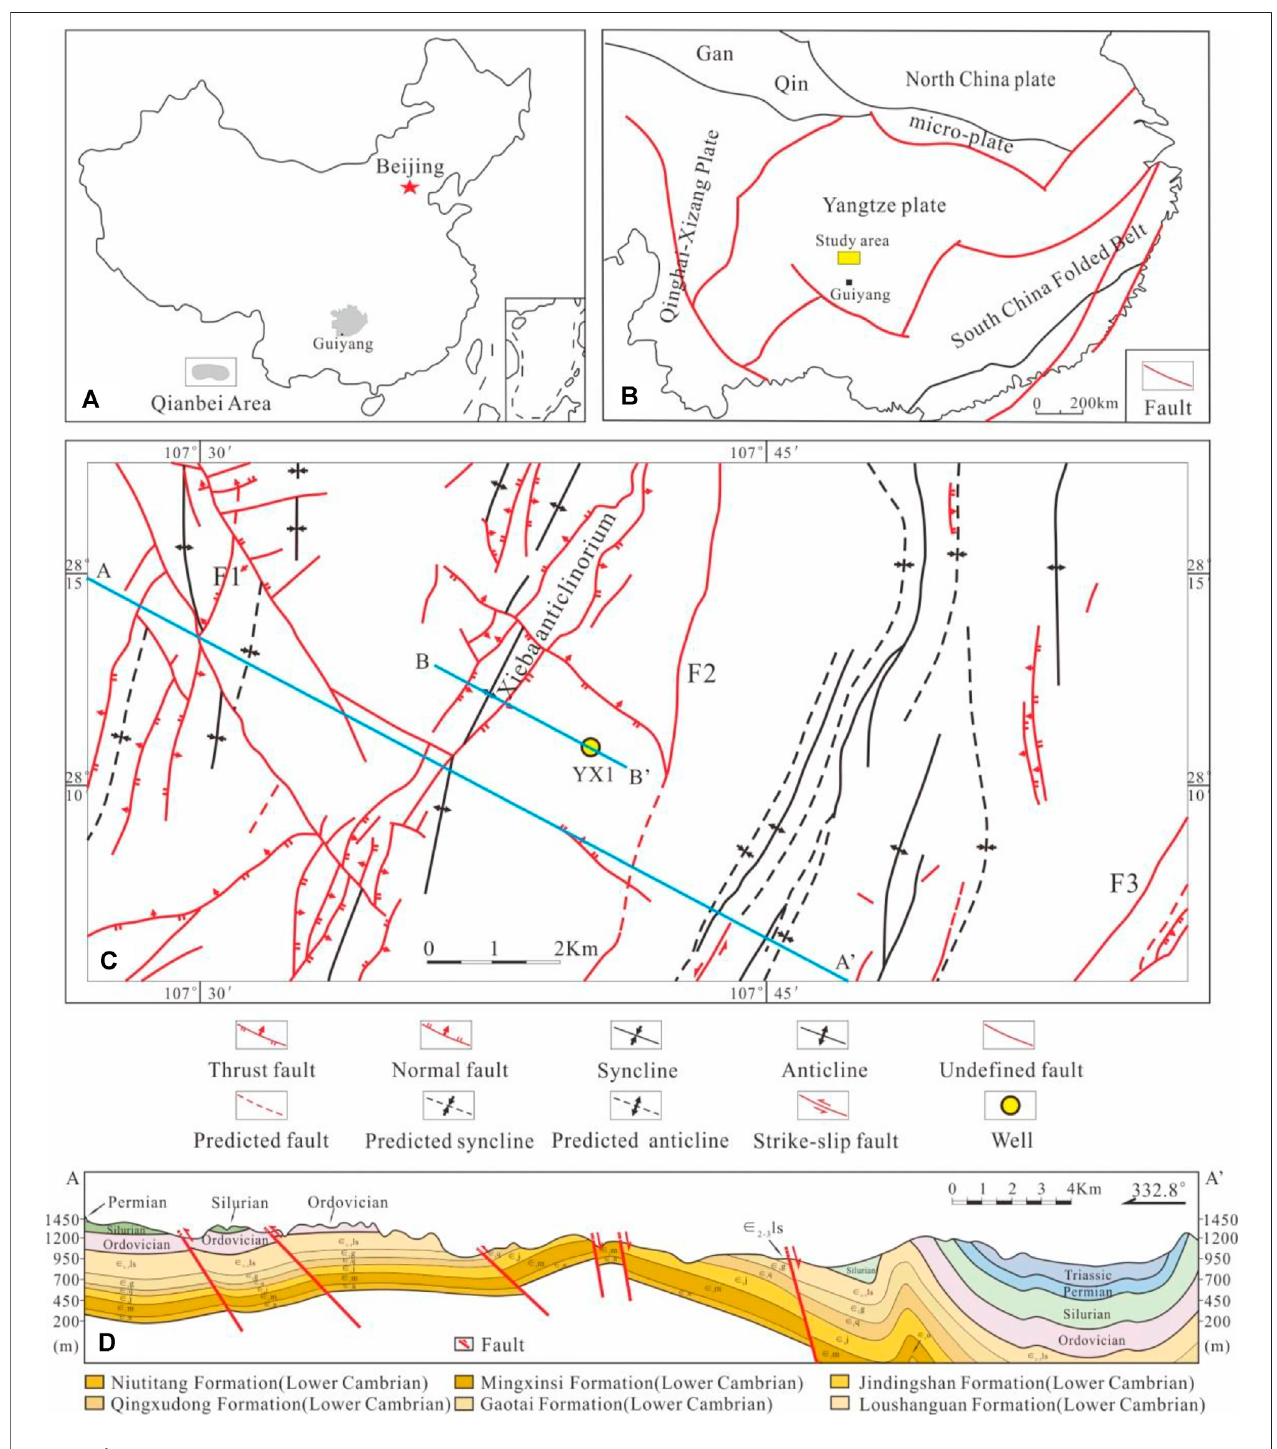
FIGURE1 | (A) Location of the Qianbei Area; (B) Location of the Yangtze plate tectonic unit with the studying area in the south of the Yangtze plate; (C) Fracture system ofthe study areaand the well location; (D) aNW-SE trending, structuralsection withthe location shown in (C) . Andthe BB ′ isthe location ofYX1well offset time pro fi le of Figure 10 .